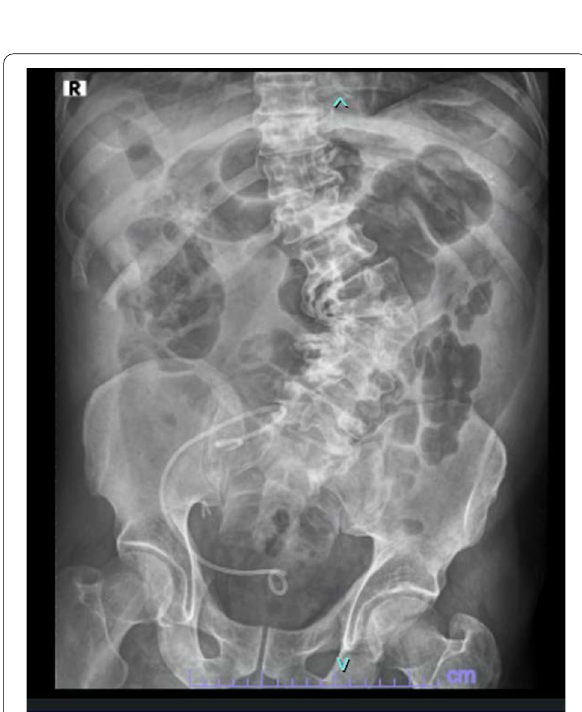
Fig. 5 Plain abdominal X-ray: JJ catheter in normal